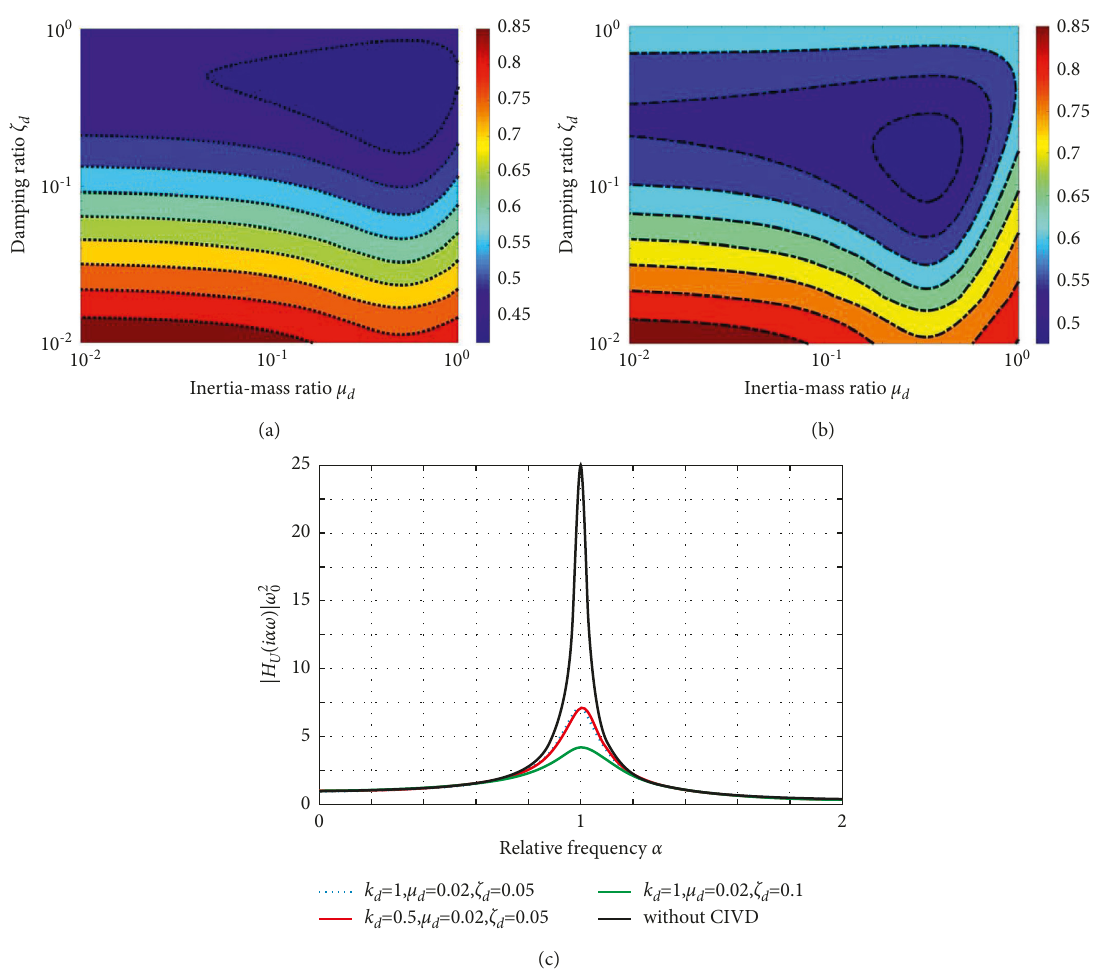
Figure 7: Isopleth of mitigation ratio of displacement response: (a) κ